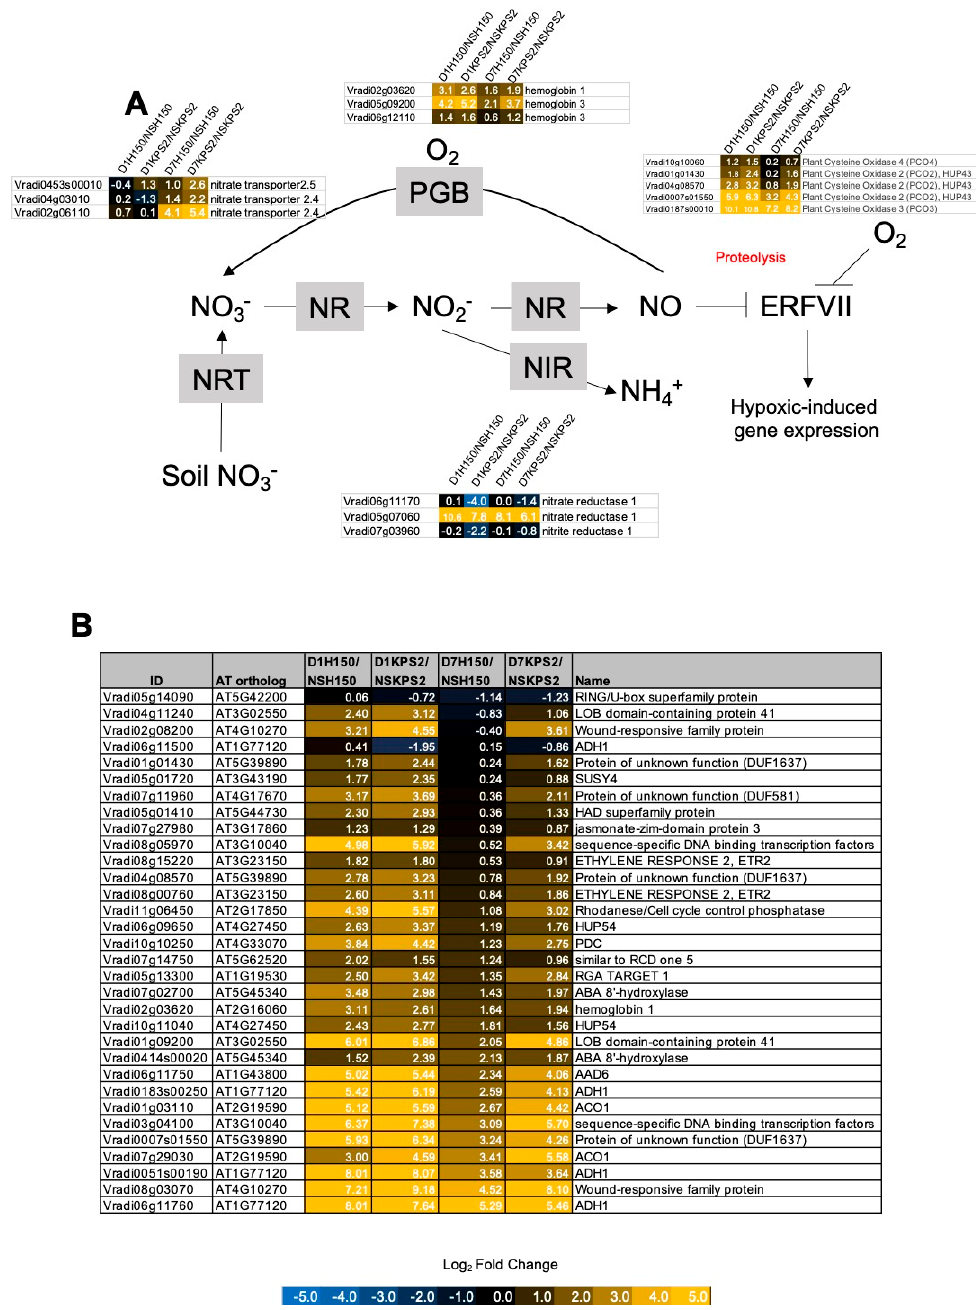
Figure 5. WS resulted in differential expression of NO production, primary nitrogen metabolism, low-oxygen sensing, and core hypoxia response genes. ( A ) NO production, primary nitrogen metabolism, and low-oxygen sensing genes ( B ) Core hypoxia genes. The number indicates log2 fold changes. Data can be found in Table S2.